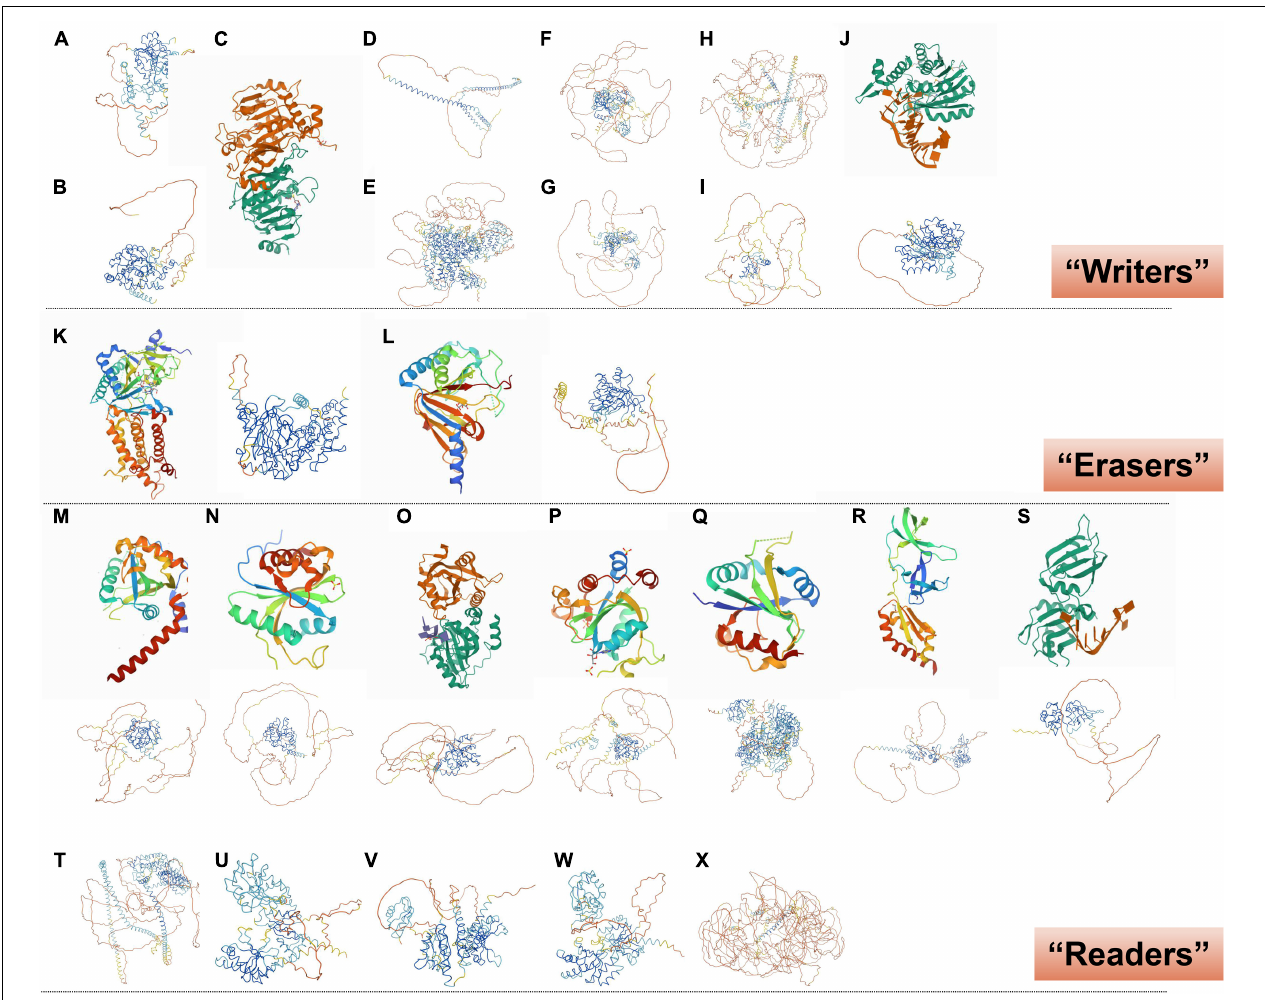
FIGURE 3 | Crystal structure of RNA m 6 A methylation-modification enzymes. (A) METTL3 and (B) METTL14, predicted from “AlphaFold.” (C) SAM-bound METTL3-METTL14 complex (Wang et al., 2016). (D) WTAP, (E) KIAA1429, (F) RBM15, (G) RBM15B, (H) ZC3H13, and (I) HAKAI, predicted from “AlphaFold.” (J) Human METTL16 catalytic domain in complex with MAT2A 3’-UTR hairpin 6 (Upper; Doxtader et al., 2018); METTL16, predicted from “AlphaFold” (Lower). (K) FTO reveals the basis for its substrate specificity (Left; Han et al., 2010); FTO, predicted from “AlphaFold” (Right). (L) Human ALKBH5 in complex with citrate and acetate (Left; Feng et al., 2014); ALKBH5, predicted from “AlphaFold” (Right). (M) YTHDF1 YTH domain (Upper; Xu et al., 2015); YTHDF1, predicted from “AlphaFold” (Lower). (N) YTH-YTHDF2 in the free state (Upper; Li et al., 2014); YTHDF2, predicted from “AlphaFold” (Lower). (O) YTHDF3 YTH domain in complex with m 6 A RNA (Upper; Li et al., 2020); YTHDF3, predicted from “AlphaFold” (Lower). (P) YTHDC1 with m 6 A (Upper; Li Y. et al., 2021); YTHDC1, predicted from “AlphaFold” (Lower). (Q) Human YTHDC2 YTH domain (Upper; Ma et al., 2019); YTHDC2, predicted from “AlphaFold” (Lower). (R) N-terminal domain of FMRP (Upper; Myrick et al., 2015); FMRP, predicted from “AlphaFold” (Lower). (S) HNRNPA2B1 in complex with RNA (Upper; Wu et al., 2018); HNRNPA2B1, predicted from “AlphaFold” (Lower). (T) Eif3, (U) IGF2BP1, (V) IGF2BP2, (W) IGF2BP3, and (X) PRRC2A, predicted from